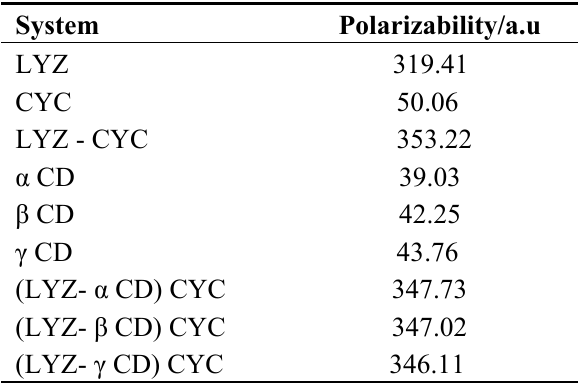
Table 3. Calculated effect of polarizabilities and energies of LYZ with CYC in the presence of